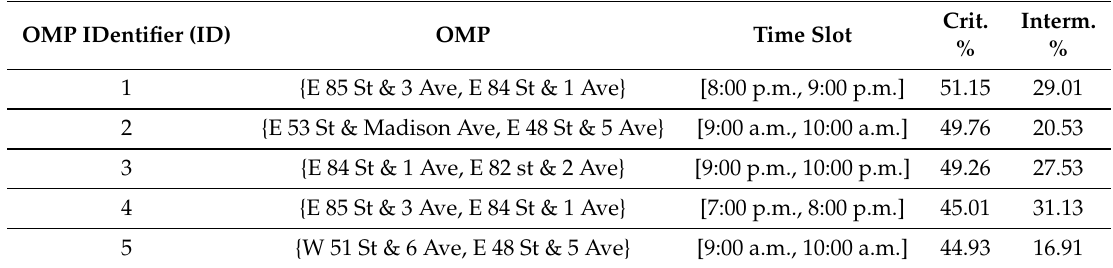
Table 6. Citi Bike (New York). Groups of stations with maximal criticality in different hourly time slots. OMP IDentifier